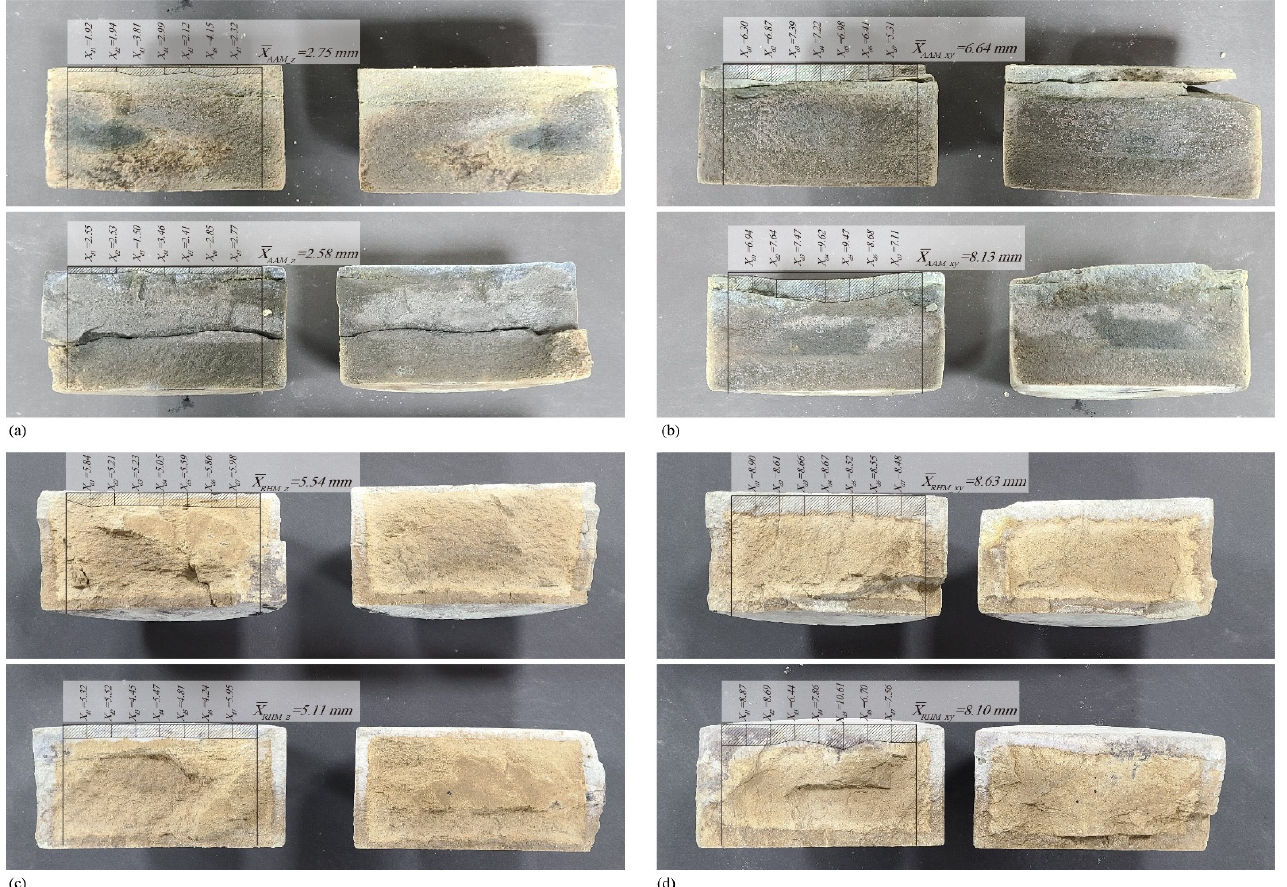
Figure 7. Chloride diffusion test results: ( a ) alkali-activated material (AAM) build direction, ( b ) AAM transverse direction, ( c ) rapid hardening mortar (RHM) build direction, and ( d ) RHM transverse direction.